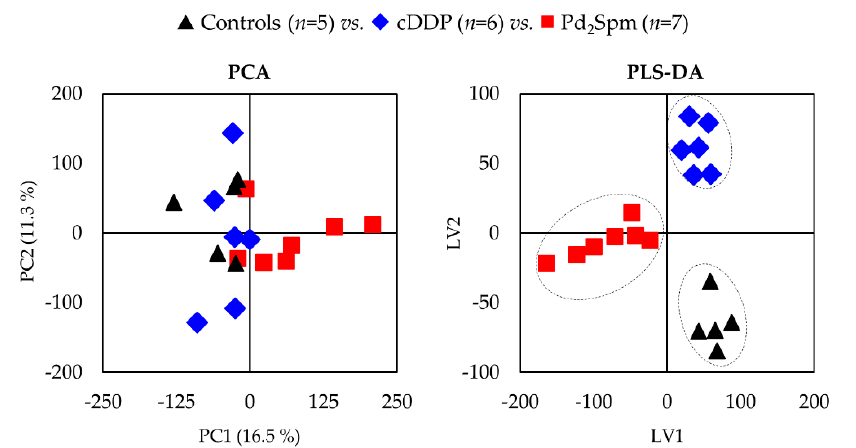
Figure 2. Principal component analysis (PCA) and partial least squares–discriminant analysis (PLS-DA) scores scatter plots for 1 H NMR spectra of aqueous extracts of tumors from MDA-MB-231 CDX mouse model after exposure to PBS (black triangles, n = 5), cDDP (blue diamonds, n = 6), and Pd 2 Spm (red squares, n = 7).